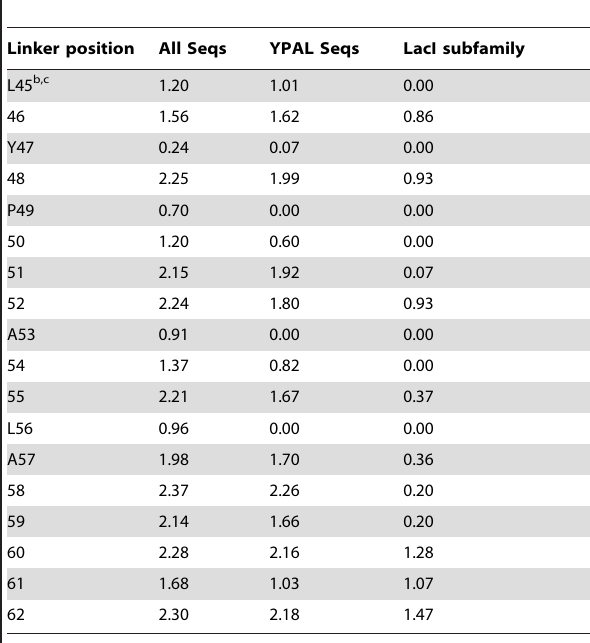
Table 2. Sequence entropies a of LacI/GalR linker positions, calculated from various